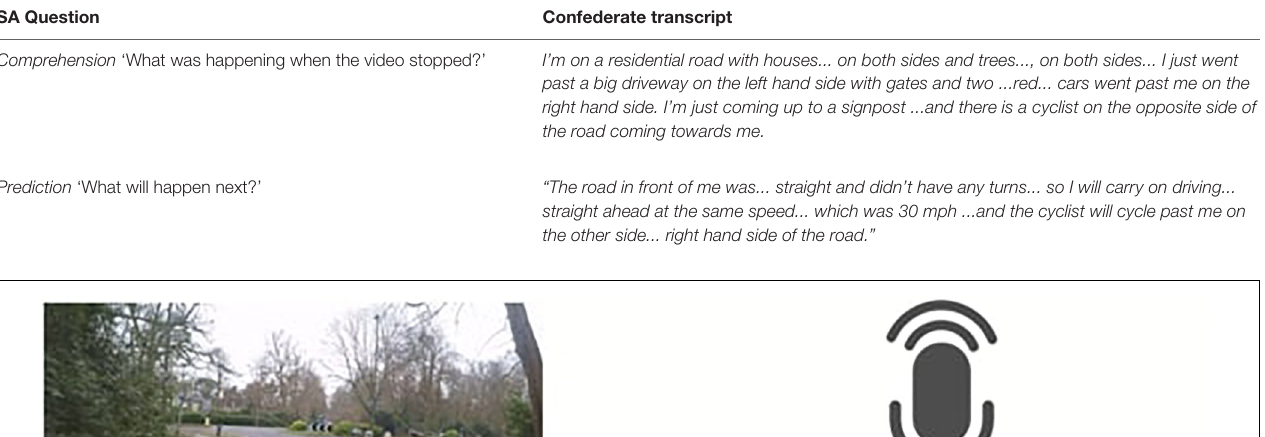
TABLE 2 | Example audio played to participants during the practice trial.